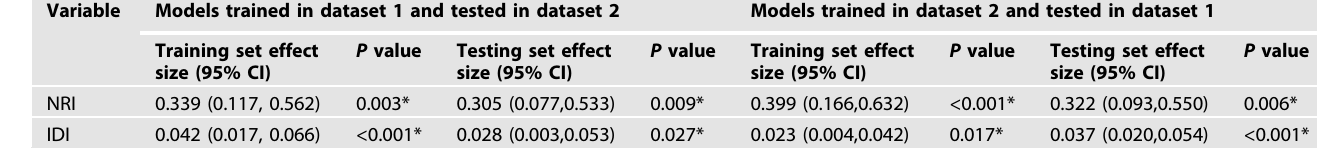
Table 3. Improvement of model performance after introduction of SDC score (enhanced model vs basic model) in split-half analyses. Variable Models trained in dataset 1 and tested in dataset 2 Models trained in dataset 2 and tested in dataset